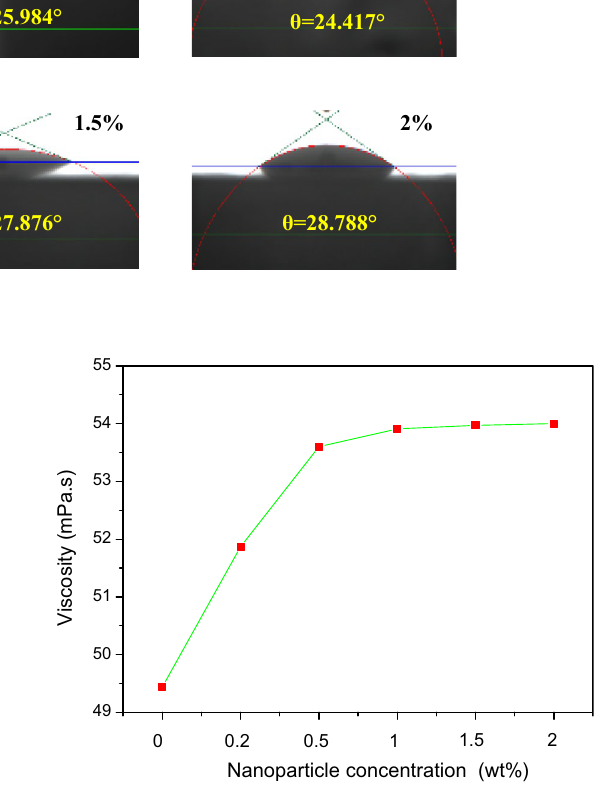
Figure 9 Viscosity under different nanoparticle